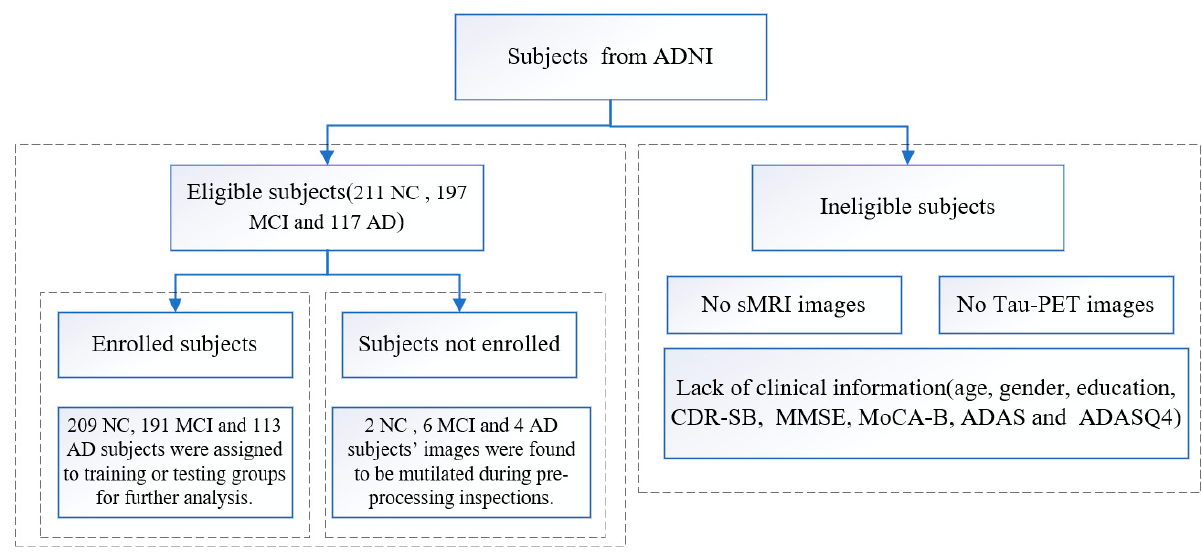
Figure 2. The flow chart of the data inclusion/exclusion criteria. The inclusion criteria of MCI were according to the criteria proposed by Jak and Bondi in 2014 [5]: (1) Scores obtained in at least one cognitive domain (memory, language or speed, executive function) were below the standard deviation of the age/education corrected normative mean; (2) scores in each of the three cognitive domains of memory, language and speed/executive function were found to be impaired; (3) Scores on the Functional Activities Questionnaire (FAQ) ≥ 9. The diagnosis of AD was primarily based on guidelines provided by the National Institute on Aging (NIA) and the Alzheimer’s Association